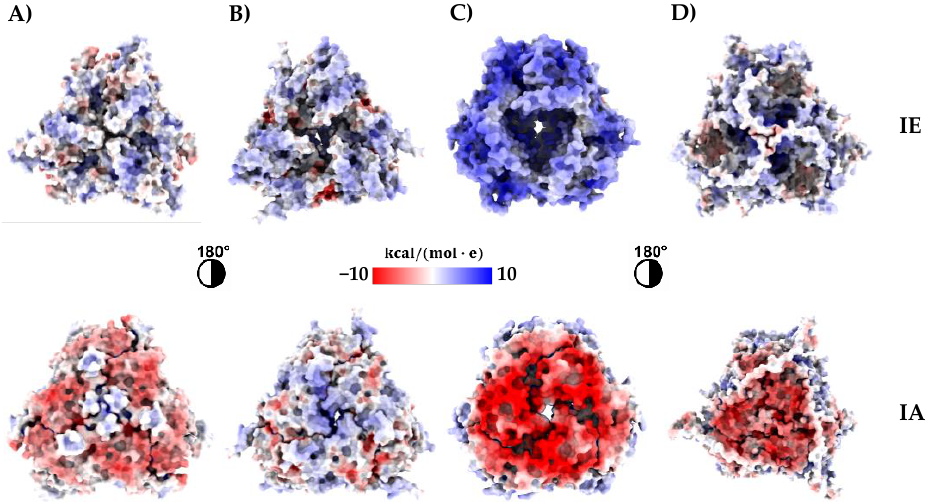
Figure 5. Surface electrostatic potential map of Ah11Sn paralogs. ( A ) Ah11SA (3QAC); ( B ) Ah11SB; ( C ) Ah11SC; ( D ) Ah11SHMW. IA: intrachain disulfide bond face; IE: interchain disulfide bond face.